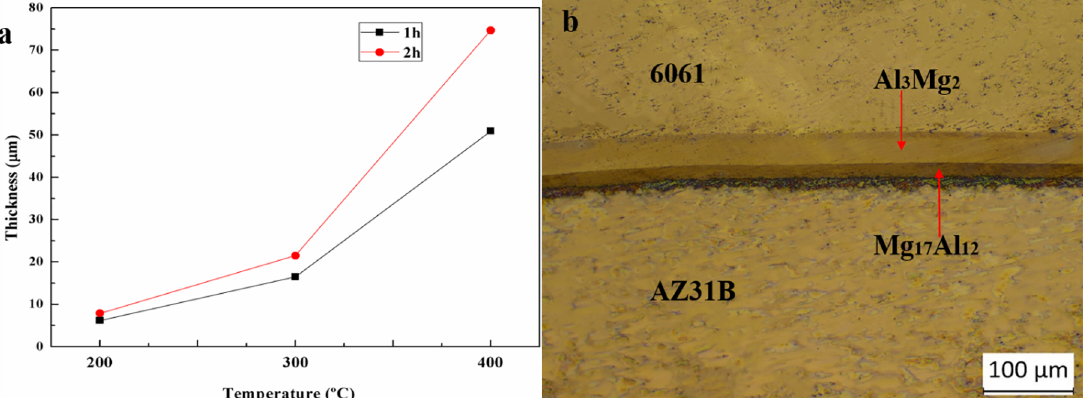
Figure 8. (a) The thickness of interface diffusion layer of rolled composite plates under various annealing conditions and (b) the interface morphology of rolled sample annealing at 400°C for 1h.